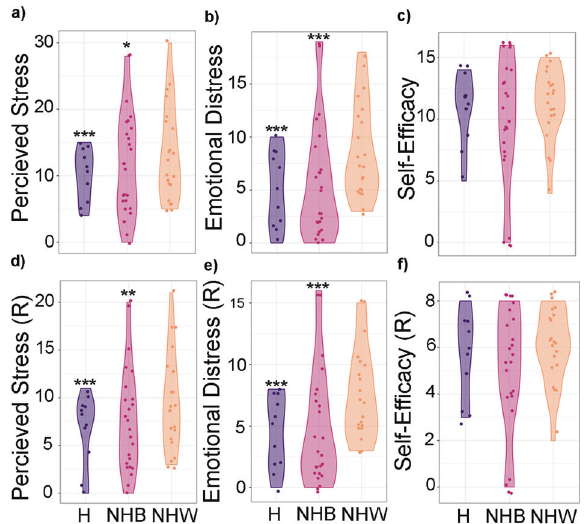
Fig. 1 Total PS (PSS-10), ED and SE scores, including the reduced form of PSS-10 per race and ethnicity. While the levels of Total PS and ED ( a , b ) as well as their reduced forms ( d , e ) were higher in non-Hispanic White individuals, we observed no statically signi fi cant differences in SE ( c ) nor in the rSE values ( f ). R reduced, H Hispanic/ Latina, NHB Non-Hispanic Black, NWH Non-Hispanic White; * p < 0.05; ** p < 0.01; *** p < 0.001.